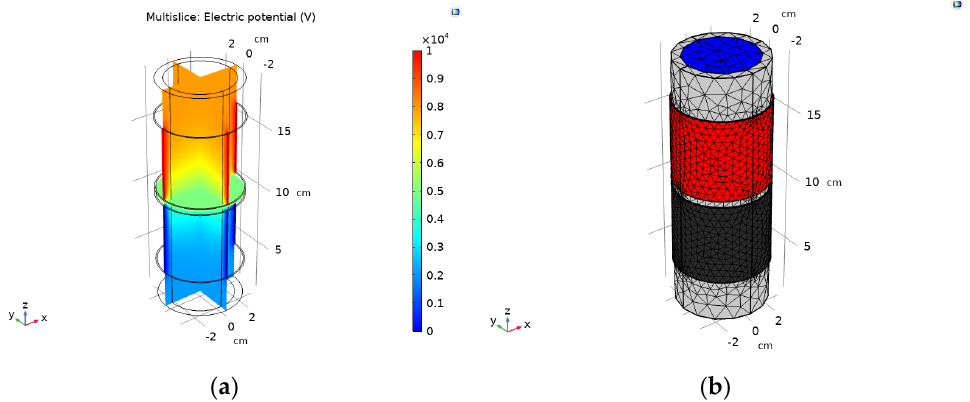
Figure 6. Double-ring sensor in stratified two-phase flow simulation ( a ) schematic of electric potential where red color represents high potential and blue color represents low potential, ( b ) meshed model.